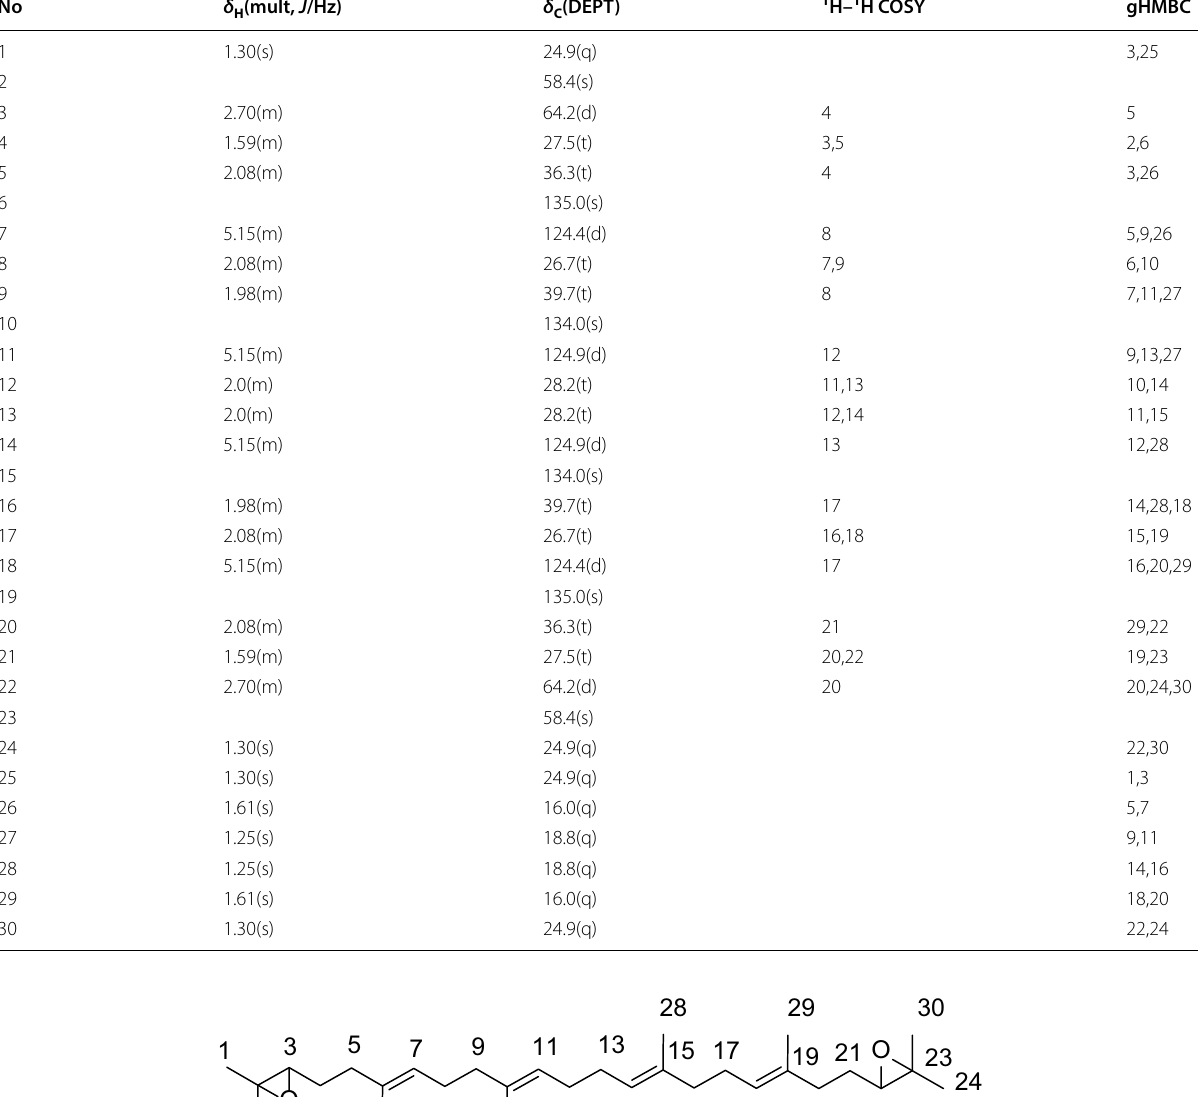
Table 3 NMR data of